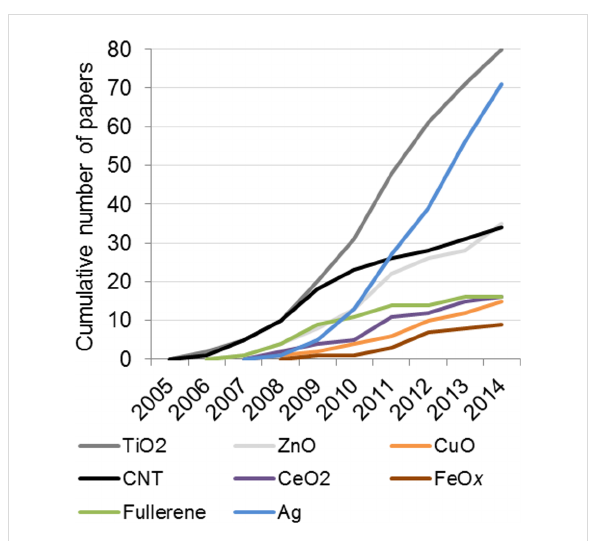
Figure 3: Evolution of nanoecotoxicological information about eight different nanomaterials according to the number of papers in NanoE- Tox database. The database entries were selected based on biblio- metric data search in Thomson Reuters WoS using the keywords as indicated in Table 1 as of January 6,